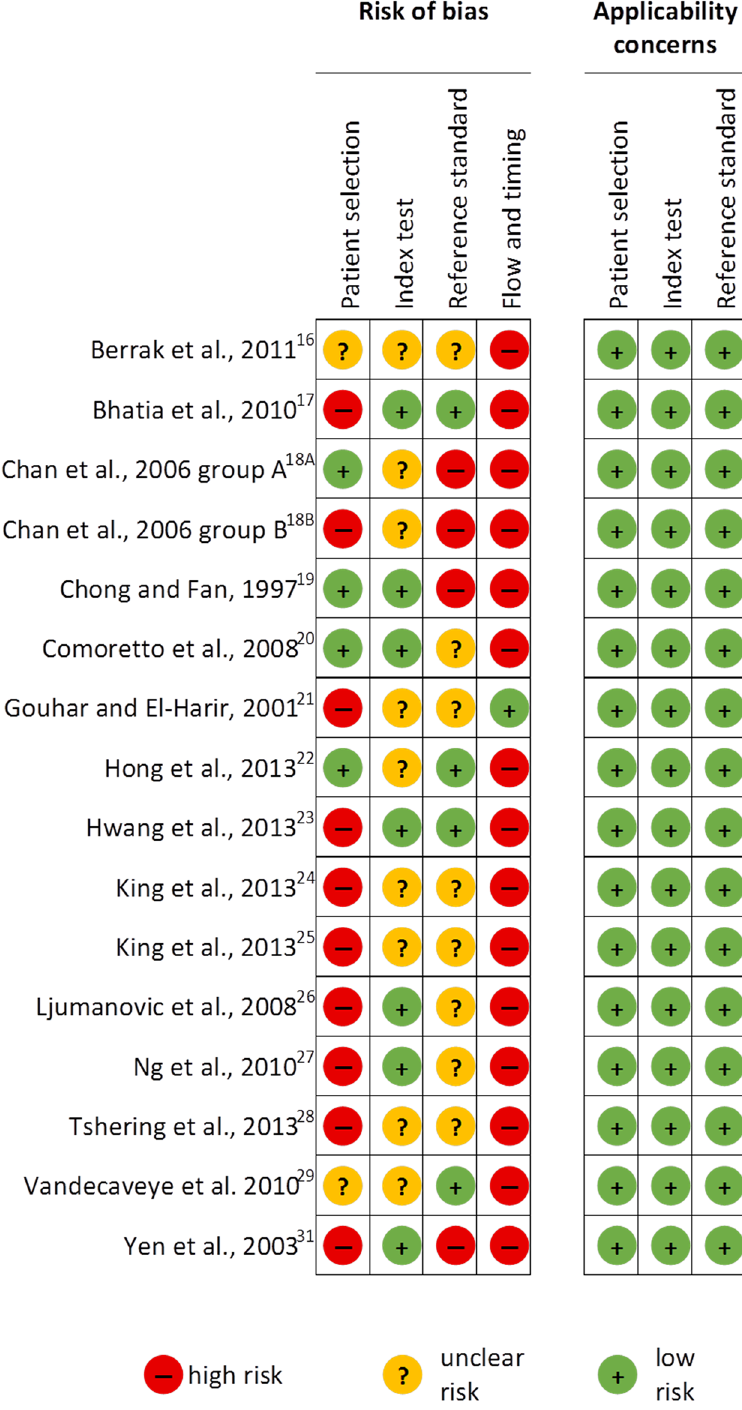
PLOS ONE | https://doi.org/10.1371/journal.pone.0177986 May 24,